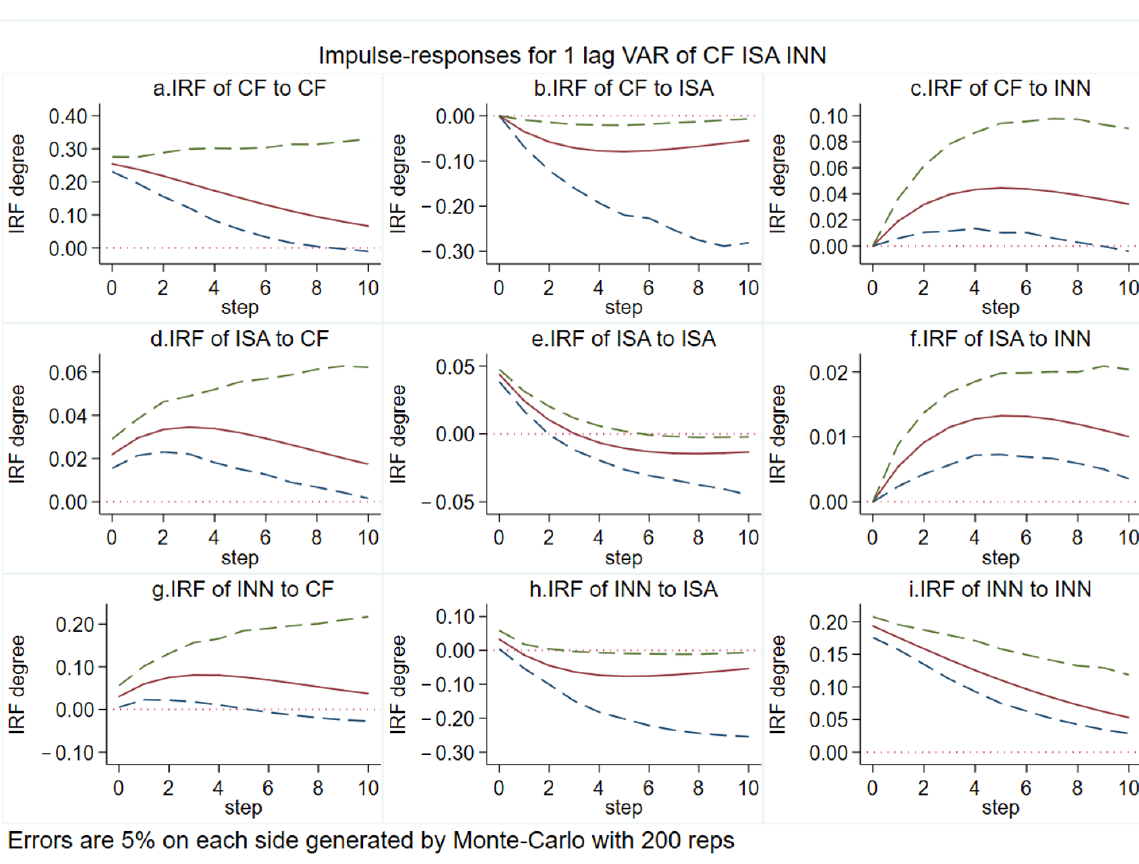
Figure 6. Impulse −re sponse function. Figure source: authors’ own creation. Figure 6. Impulse-response function. Figure source: authors’ own